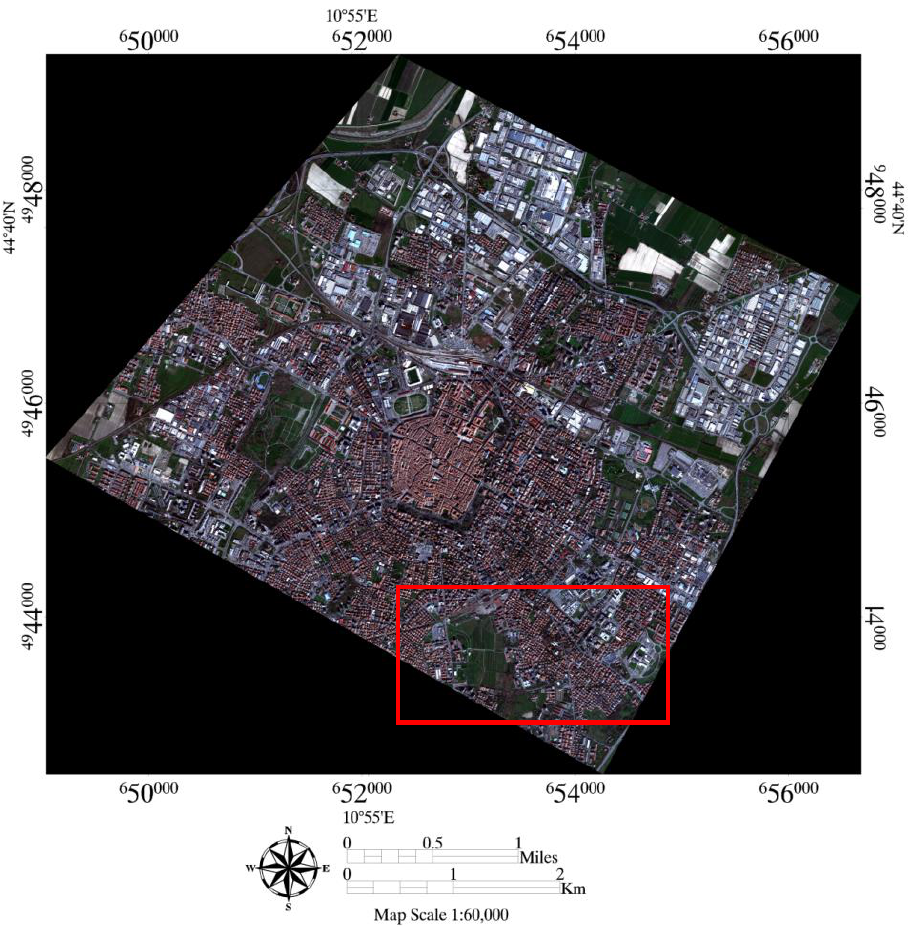
Figure 5. WV3 satellite image and area of investigation (red boxed).